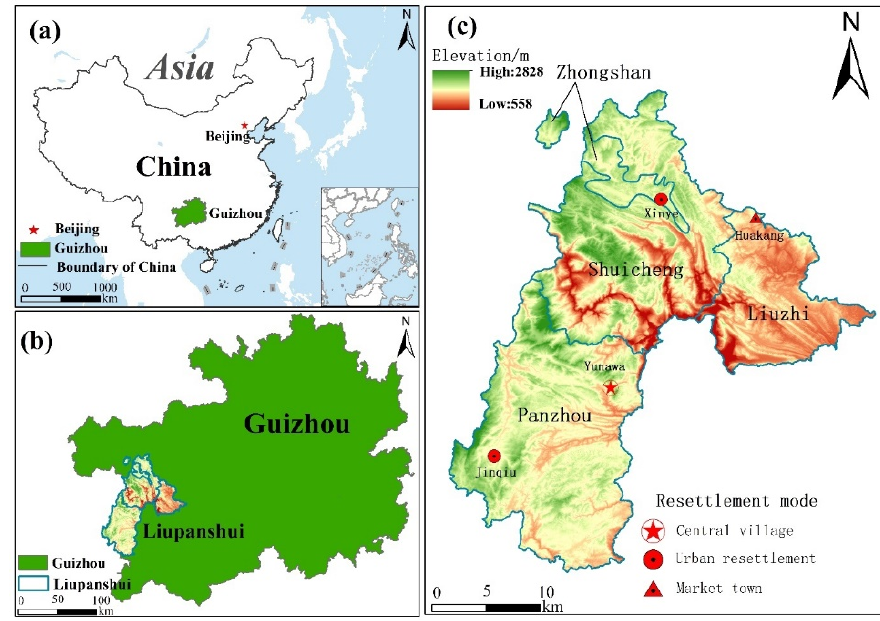
Figure 1. Location and structures of the study